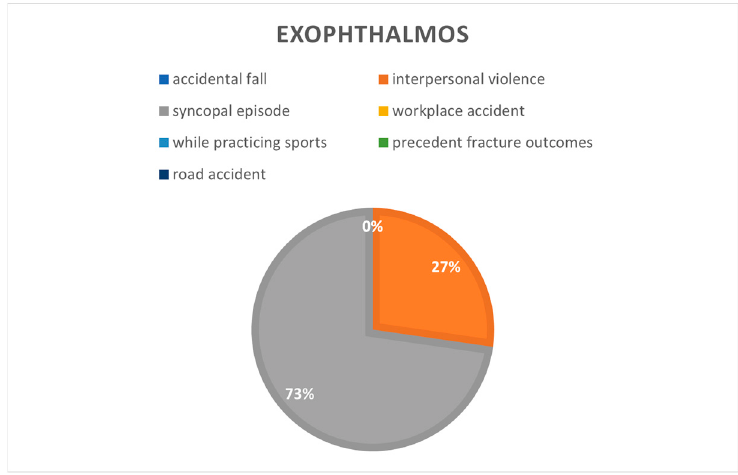
Figure 5. Exophthalmos correlated to cause of the fractures. Enophthalmos (Figure 6) were present in 42% of patients who had previously under- gone surgery for orbital wall fractures ( n = 6), 12% in interpersonal violence cases ( n = 8) and in 1.3% of accidental falls ( n = 2).